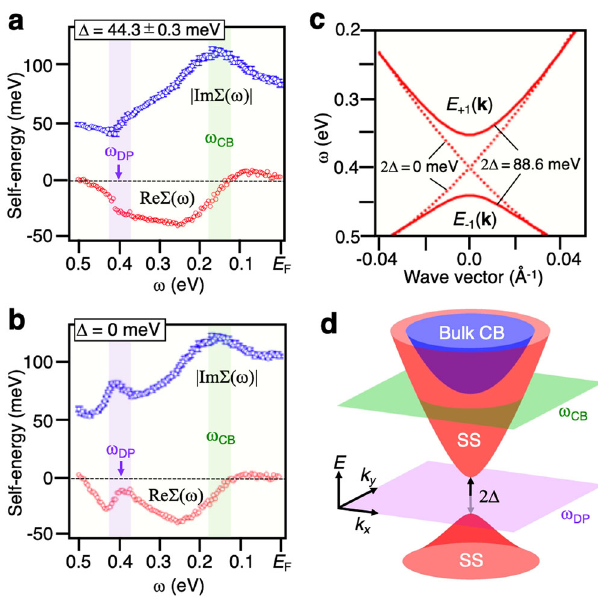
Fig. 4 Signature of many-body effects in the Dirac electrons. a , b Real (red open circles) and imaginary (blue open circles) parts of electron self- energy (Re Σ ( ω ) and |Im Σ ( ω )|) extracted from the semiparametric Bayesian analysis for the gapped ( Δ = 44.3 ± 0.3 meV) and gapless ( Δ = 0) cases, respectively. Here ω and Δ denote the binding energy and the half-width of band gap, respectively. c Bare-band dispersion for the gapped (red solid curves) and gapless (red dotted curves) Dirac cones used in a , b . d Schematic band diagram of bulk and gapped Dirac-cone bands, together with the energy slices ( ω DP and ω CB ) where the self-energy exhibits a characteristic energy dependence. Each error bar of |Im Σ ( ω )| denotes the posterior standard deviation, where each pro fi le of Re Σ ( ω ) calculated from each pro fi le of |Im Σ ( ω )| satis fi es the Kramers – Kronig relation under assumption of the particle – hole